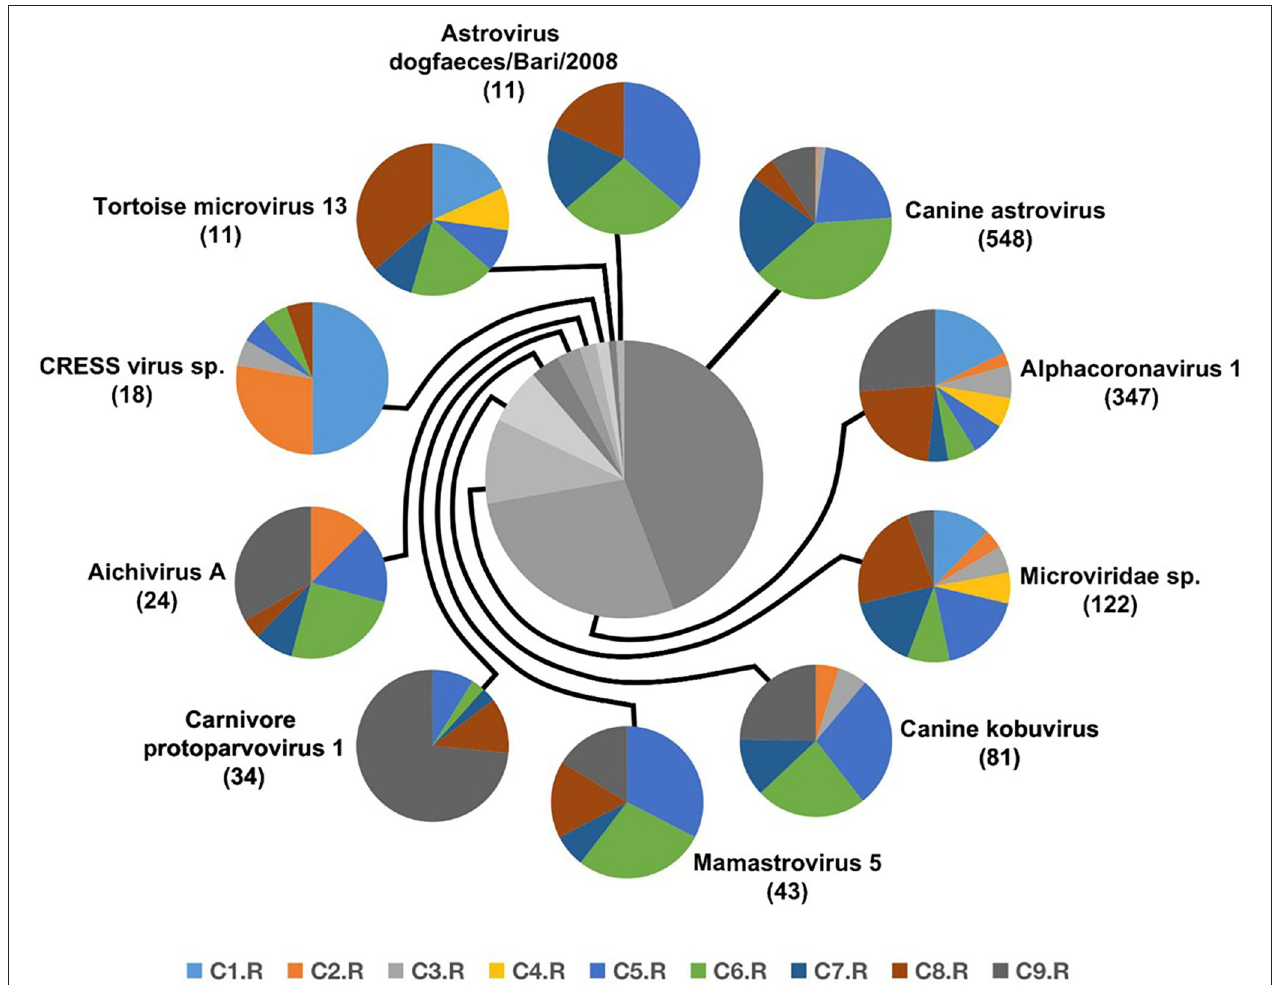
FIGURE 5 | The composition of eukaryotic RNA viruses detected in dog gut virome. The center pie chart indicated the approximate percentages of the ten virus groups detected in all nine databases. The circumjacent smaller pie charts showed the approximate percentage of virus sequence from different databases. The databases are shown in different